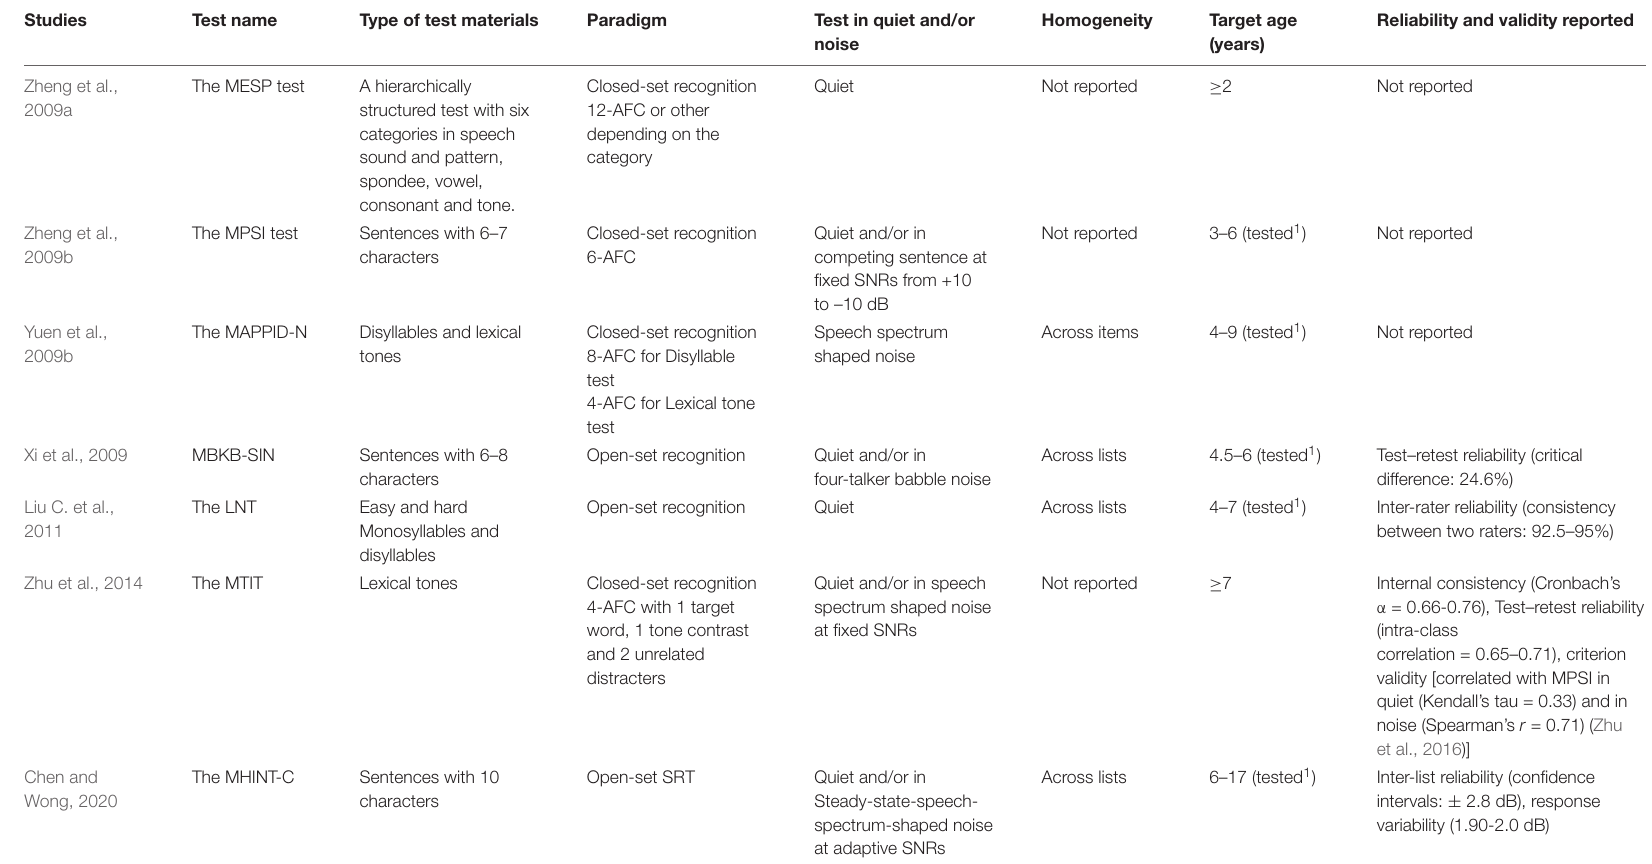
TABLE 2 | Speech perception